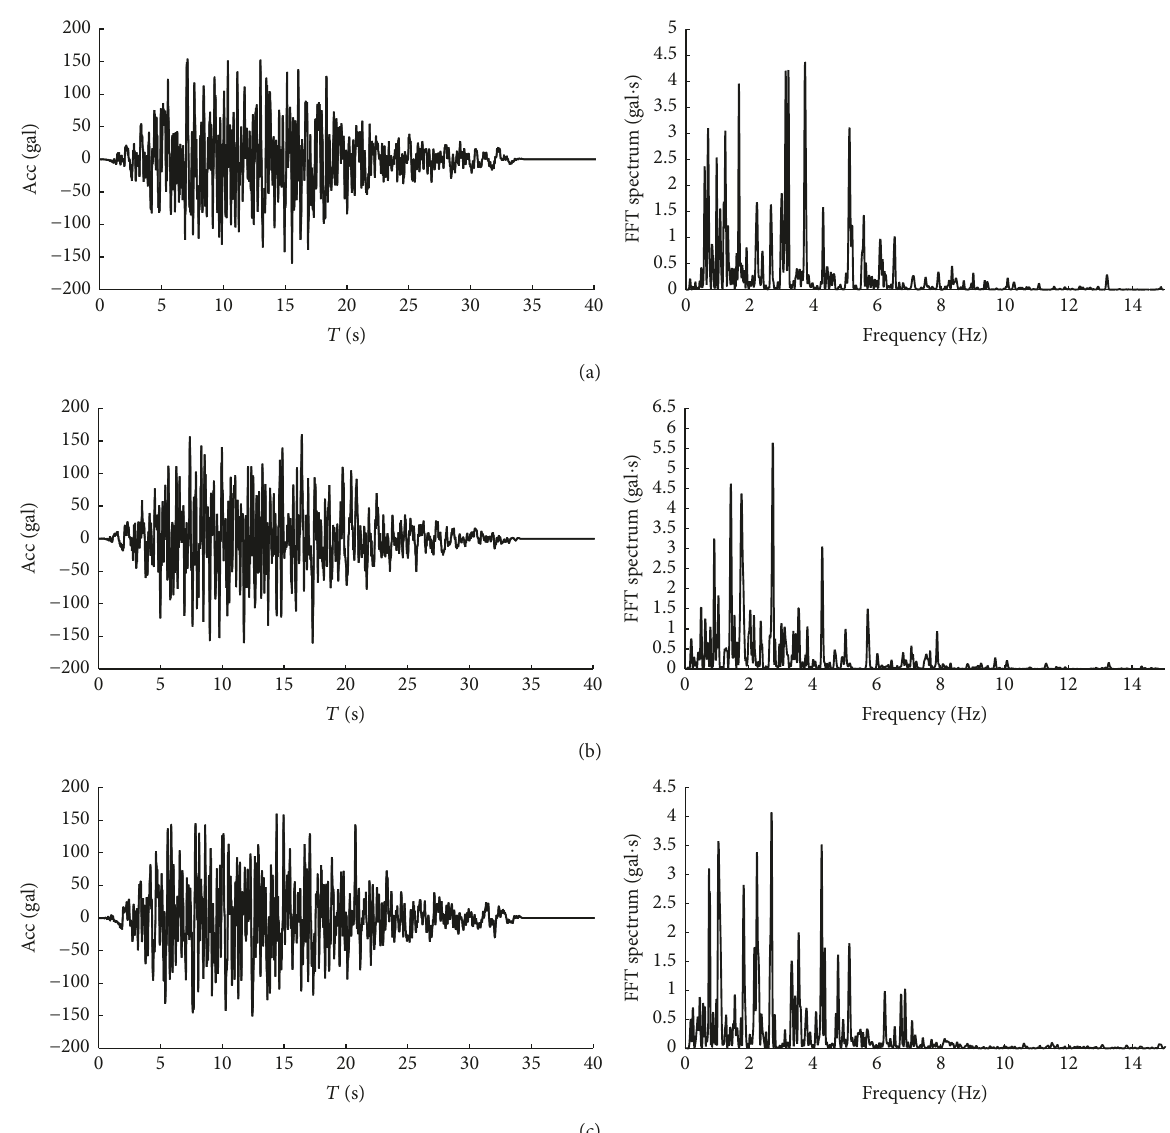
Figure 1: The artificial seismic waves with exceedance probabilities of 10% in 50 years: (a) schedule 1 of the seismic waves; (b) schedule 2 of the seismic waves; (c) schedule 3 of the seismic